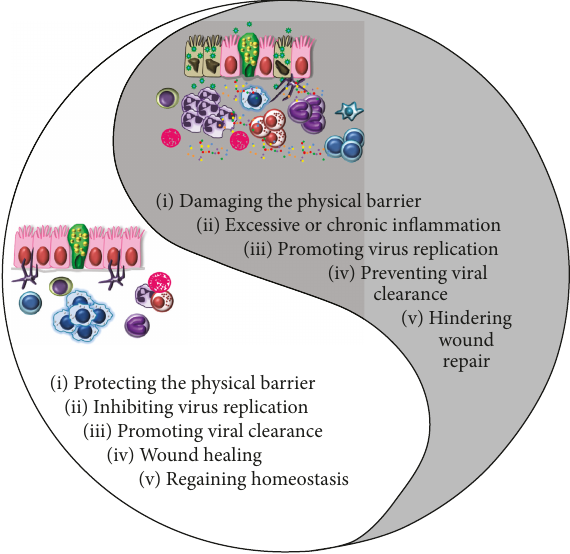
Figure 5: Yin and Yang of innate immune cell functions during in fl uenza virus infection. At steady state, innate immune cells corporate to maintain pulmonary homeostasis while clearing IAV e ff ectively with minimal tissue damage. When infected with a highly pathogenic virus or when immediate immune responses are unable to clear the infection, the immune system goes on overdrive causing excessive proin fl ammatory cytokine production and uncontrolled in fl ammation which can be pathogenic and detrimental to the